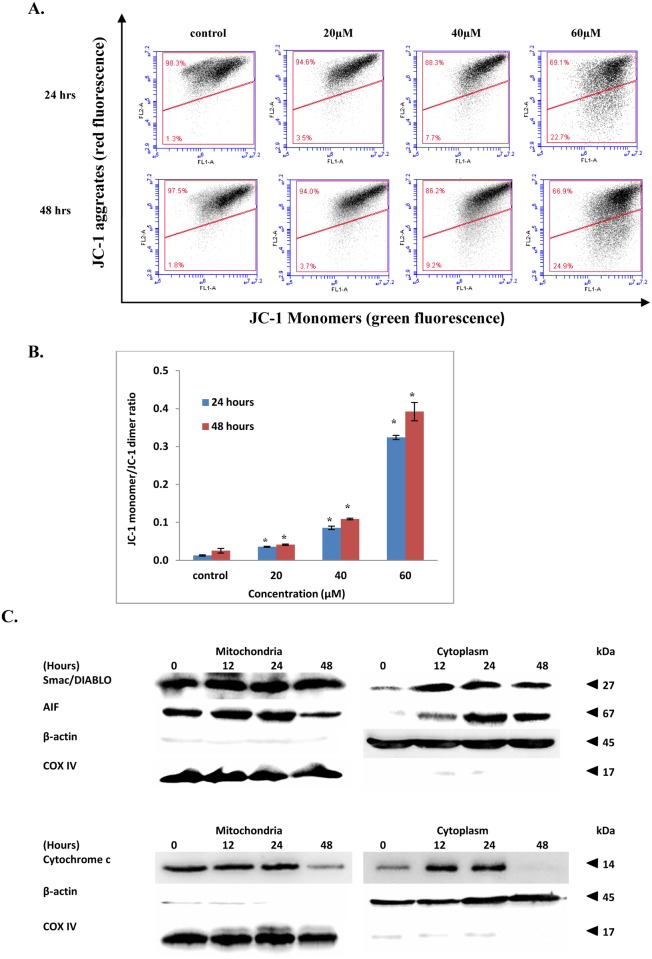
FKC causes dissipation of mitochondrial membrane potential in HCT 116 cells.(A) Cells were treated with the indicated concentrations of FKC for 48 hours. Cells were then incubated with JC-1 probe, and then analyzed using flow cytometry. Untreated cells in 0.5% DMSO served as the control. Upper quadrant indicates percentage of cells with polarized mitochondrial membranes which emit red fluorescence whereas bottom quadrant indicates percentages of cells with depolarized mitochondrial membranes which emit green fluorescence. Each dot plot is the representative result of three independent experiments. (B) The bar charts showing the ratio of mean intensity of JC-1 red fluorescence to JC-1 green fluorescence in HCT 116 cells treated with various concentrations for 24 and 48 hours. Values given are expressed as mean±SD of triplicates obtained from three independent experiments. The asterisk (*) indicated p<0.05 when compared to the control. (C) After treatment with FKC, whole cell lysate was fractionated into cytosolic and mitochondrial portions. Western blotting was used to examine the levels of cytochrome c, smac/DIABLO and AIF in both fractions of HCT 116 cells at indicated time points after FKC treatment (60μM). β-actin and COX IV were served as loading control for cytoplasm and mitochondria, respectively.